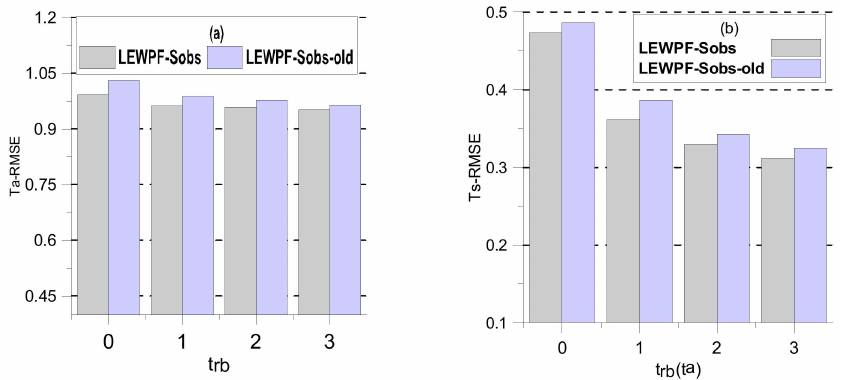
Figure 5. The annual average RMSE with different start moment of statistical observation t rb for the LEWPF-Sobs. ( a ) The average RMSE of T a . ( b ) As ( a ) but for the T s